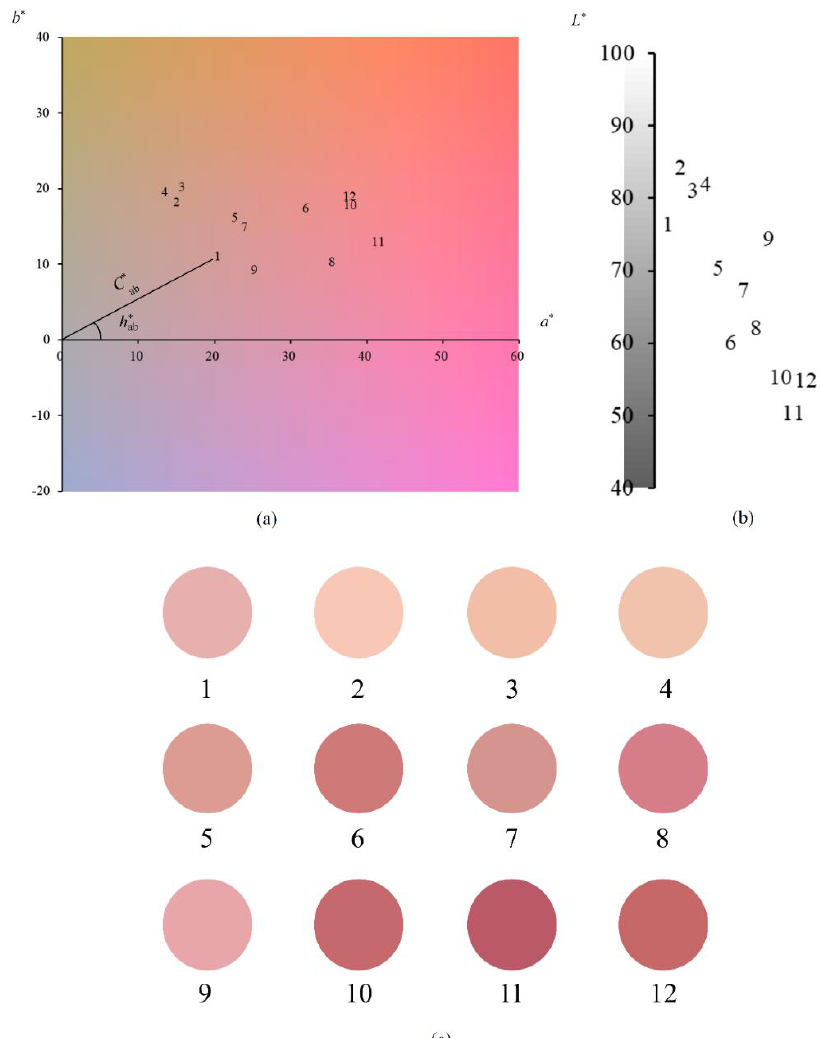
Figure 1. Chromaticity distribution plane ( a ), lightness distribution plane ( b ) and feature colors ( c ) of 12 red wine samples. The feature color contains all the contributions of L *, a * and b *. In CIELAB system, L *, a * and b * construct a three-dimensional color space, of which the parameter L * expresses the lightness information. For the D65 illuminant, the values of L * range from 0 (black) to 100 (white) [16]. The L * value’s range for the 12 red wine samples is 50.46 (wine sample No. 11) to 84.19 (No. 2); the L * values of different samples vary significantly from each other (Table 1). Corresponding to the lightness distribution plane (Figure 1b), the overall lightness distribution of the 12 wine samples and the lightness feature of each wine sample are clear at a glance. The a * − b * plane reserves the chromatic information. The parameter a * represents the red (+)-green ( − ) color channel. The parameter b * denotes the yellow (+)-blue ( − ) color channel [17]. The 12 red wine samples have a * values between 13.47 (No. 4) and 41.46 (No. 11), of which there are significant differences between the wine samples except for No. 10 and No. 12. The b * values range from 7.05 (No. 9) to 18.06 (No. 3); the b * values of the different samples are significantly different from each other (Table